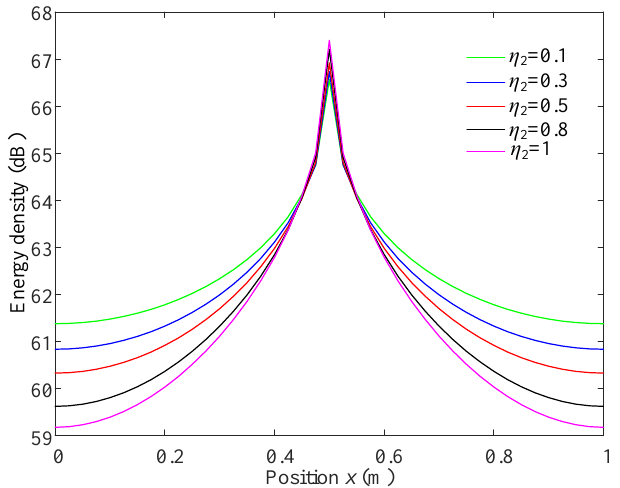
Figure 7. Energy density distribution for a plate with FFLD treatment of various loss factor of damp- ing layer ( f = 3 kHz, h 2 = 0.002 m).